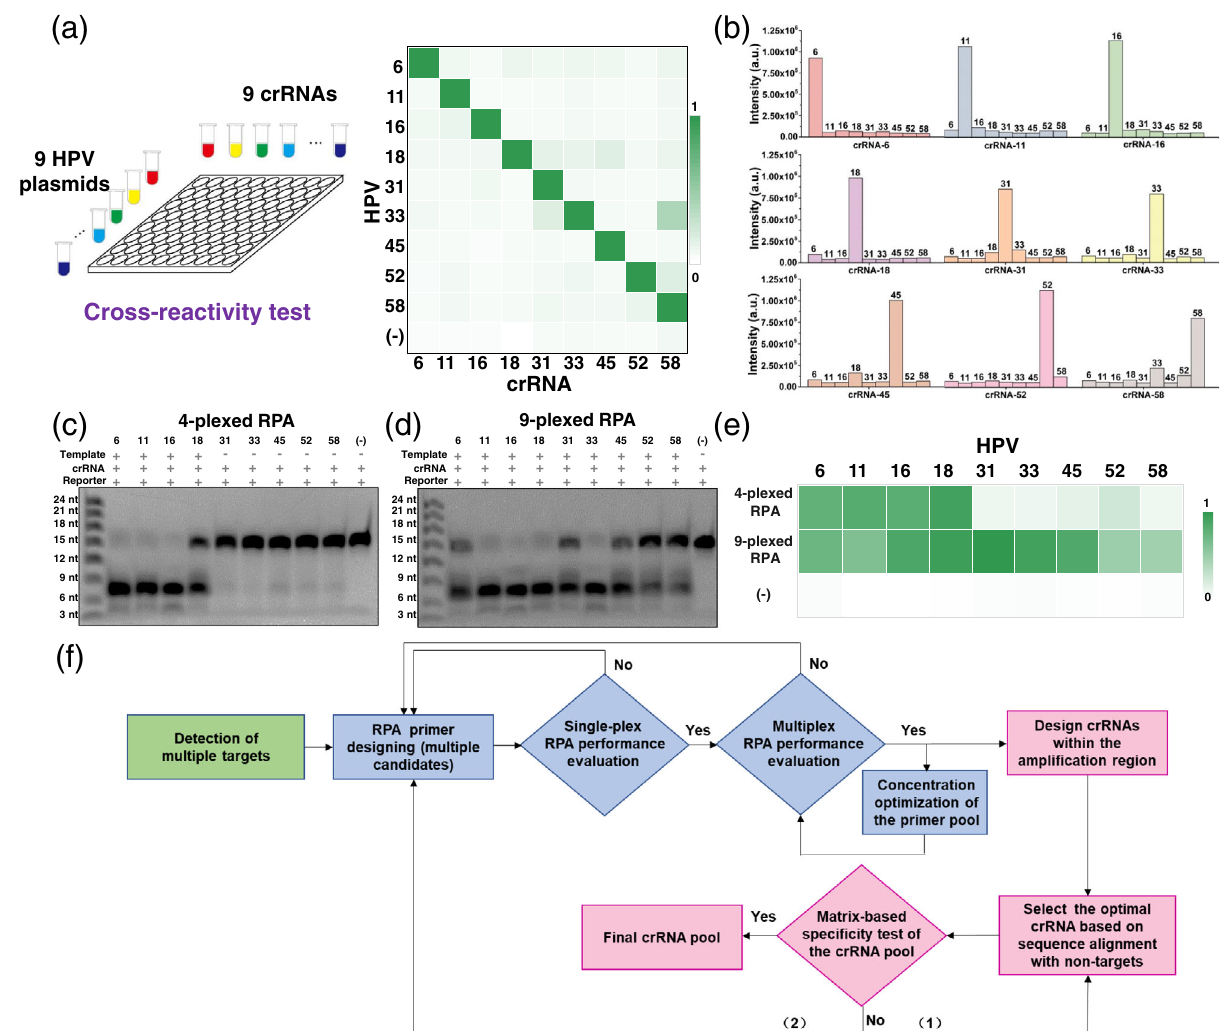
Fig. 3 | Comprehensivecharacterization ofthe performance of the crRNA pool and multiplex RPA. a Matrix-based reactivity test of the nine crRNAs against the nine HPV subtypes. The fl uorescence-based test results were demonstrated as a heatmap. Source data are provided asa Source Data fi le. b Quantitative analysis of the reaction of individual crRNAs with the nine HPV subtypes. Source data are providedasaSourceData fi le. c , d DenaturingPAGEimageshowingthecleavageof